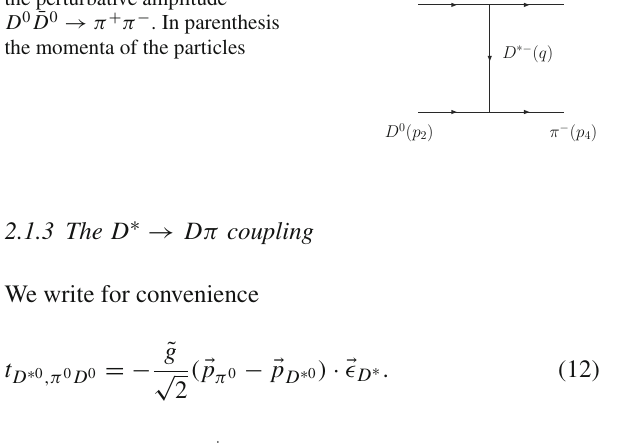
Fig. 3 Feynman diagram for the perturbative amplitude D 0 ¯ D 0 → π + π − . In parenthesis the momenta of the particles